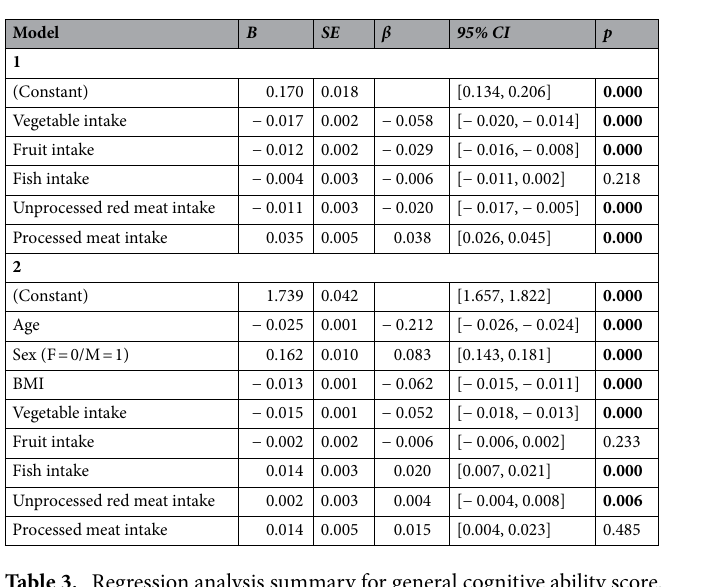
Table 3. Regression analysis summary for general cognitive ability score.